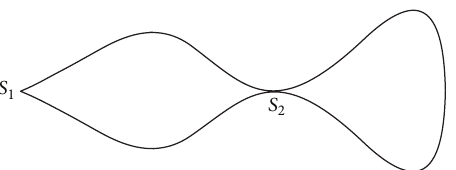
Figure 1: Compound loop with a cusp and a nilpotent